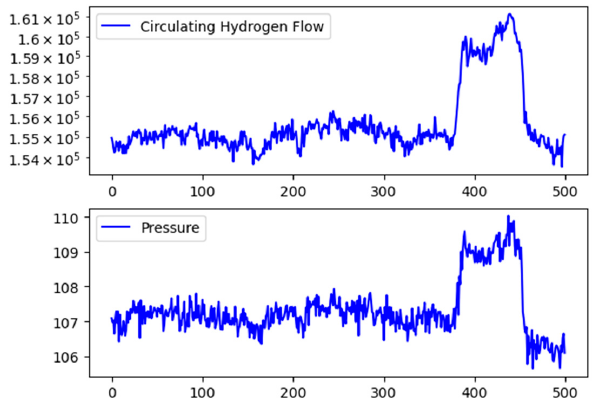
Figure 17. Original data in case one. In case two, an abnormal increase of pressure drop is detected again. However, the circulating hydrogen flow stays steady during this time. The fault diagnosis result ob- tained from the proposed method is shown in Figure 18. It can be concluded that this abnormal increase of pressure drop is caused by inlet temperature at cold side, and then outlet temperature at hot side is further influenced. According to original data in Figure 19, the pressure difference drop at hot side increases at the 350th sample, but inlet tem- perature at cold side increases as early as the 67th sample, indicating that the fault diag- nosis result is correct. The results show that the fault propagation path and the root cause can be identified by the proposed method correctly, and the proposed method can be well applied to industrial processes. Figure 18. Fault propagation digraph in case two.